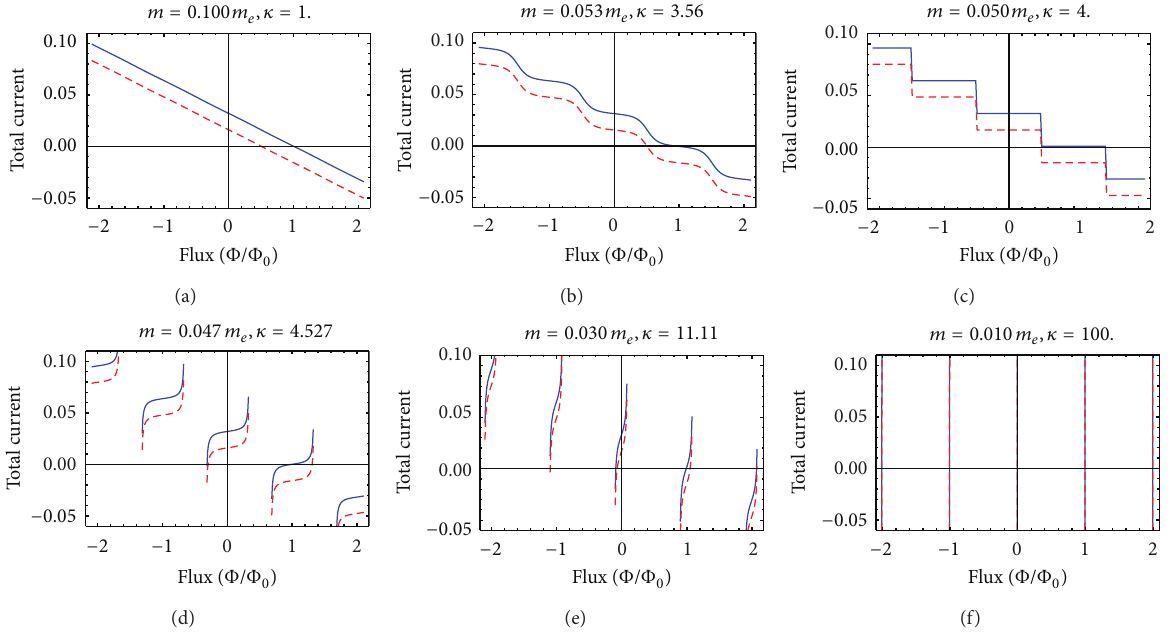
Figure 6: Total current (measured in units of 𝐼 𝑒 (Figure 3)) for 100 (Blue) and 101 (red dashed) particles in a ring with 𝑅 = 10𝑟 𝑒 ( ℎ = 𝑐 = 𝑒 = = 1 ). Masses and corresponding 𝜅 values are written on the top of each plot. For large mass, (a) total current depends linearly on flux. As 𝑚 𝑒 we decrease the mass (b) the dependence becomes nonlinear. For critical mass (12), total current is a step function of flux (c), the step heights being multiple of 𝐼 sat (13). For lower mass (d), total current tends to diverge at values given by (14), the mean position of the plateaus being multiple of 𝐼 sat . On further decrease of mass (e), the spectrum becomes narrower and the divergences come closer to the integral flux values. As we go to the zero mass limit (f), total current appears as sharp pulses at integral values of